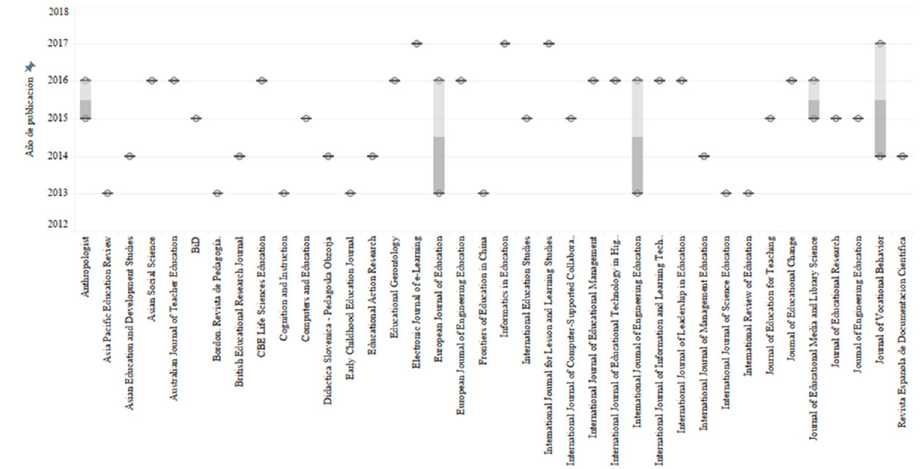
Figure 3. Distribution of the frequency of publication in the subject by year and scientific magazine. Own elaboration.